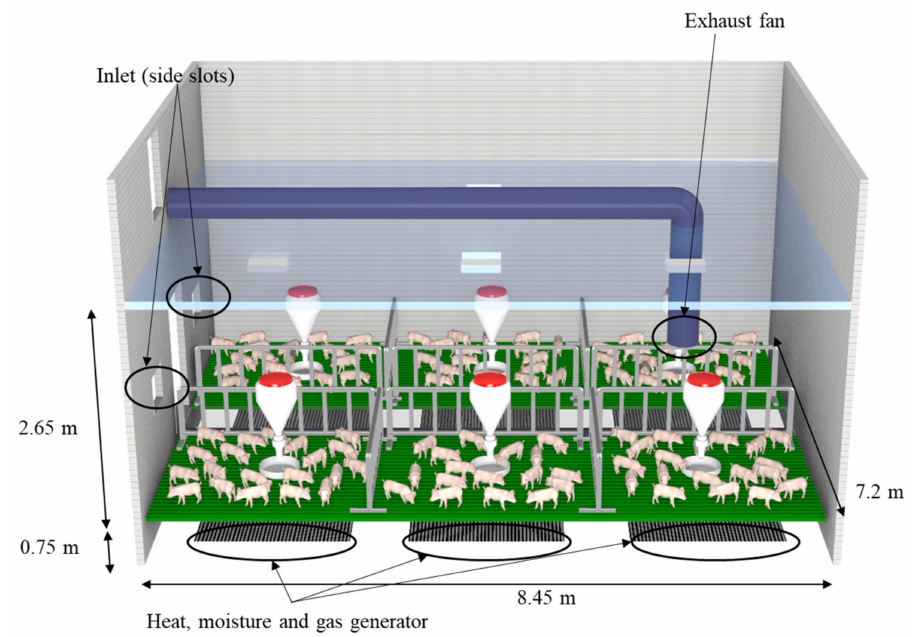
Figure 3. Schematic view of target piglet house at Artificially controlled Smartfarm Engineering Center of Aero-Environmental and Energy Engineering Laboratory (AcSEC-A3EL), Seoul National University,